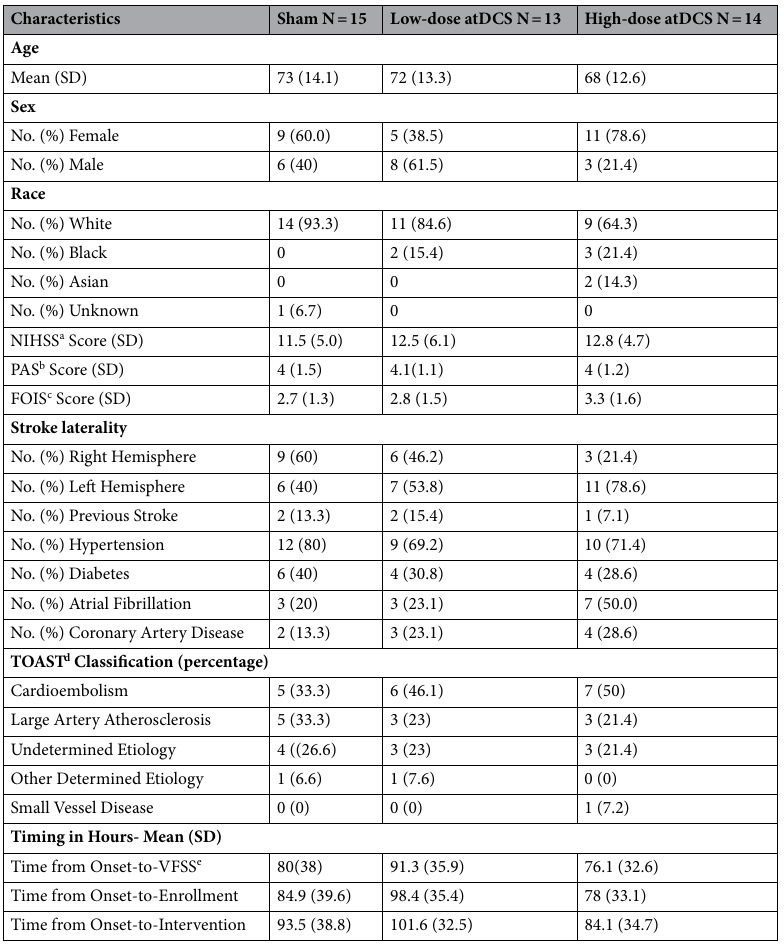
Table 1. Baseline characteristics of trial cohort in sham and anodal transcranial direct stimulation (atDCS) groups. a National Institute of Health Stroke Scale. b Penetration and Aspiration Scale. c Functional Oral Intake Scale. d Trial of Org 10,172 in Acute Stroke Treatment Classification. e Videofluoroscopic